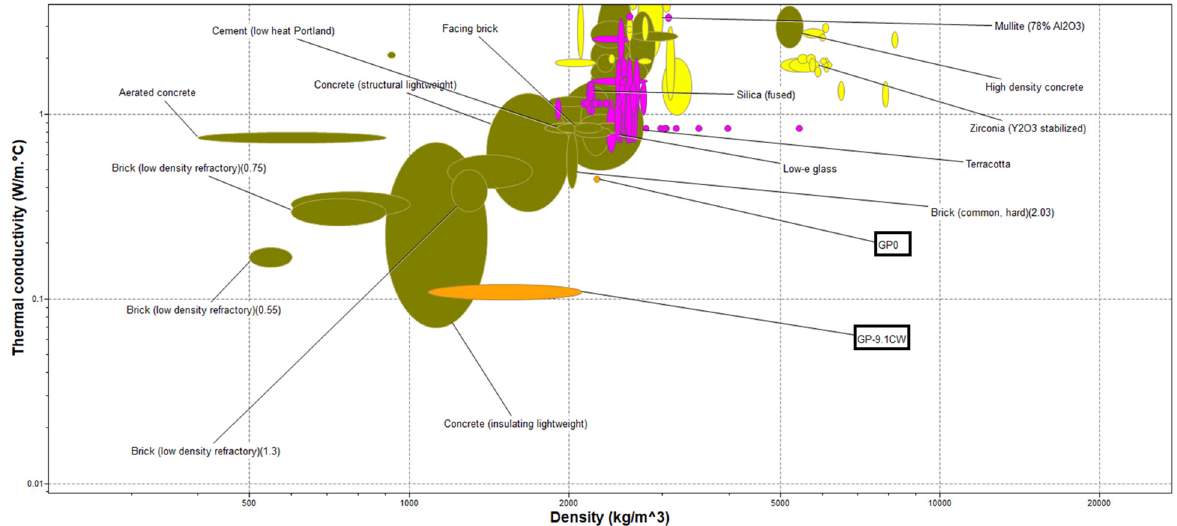
Figure 10. Ashby chart: thermal conductivity vs density for GP0 and GP0-9.1CW in comparison to other insulating inorganic materials.